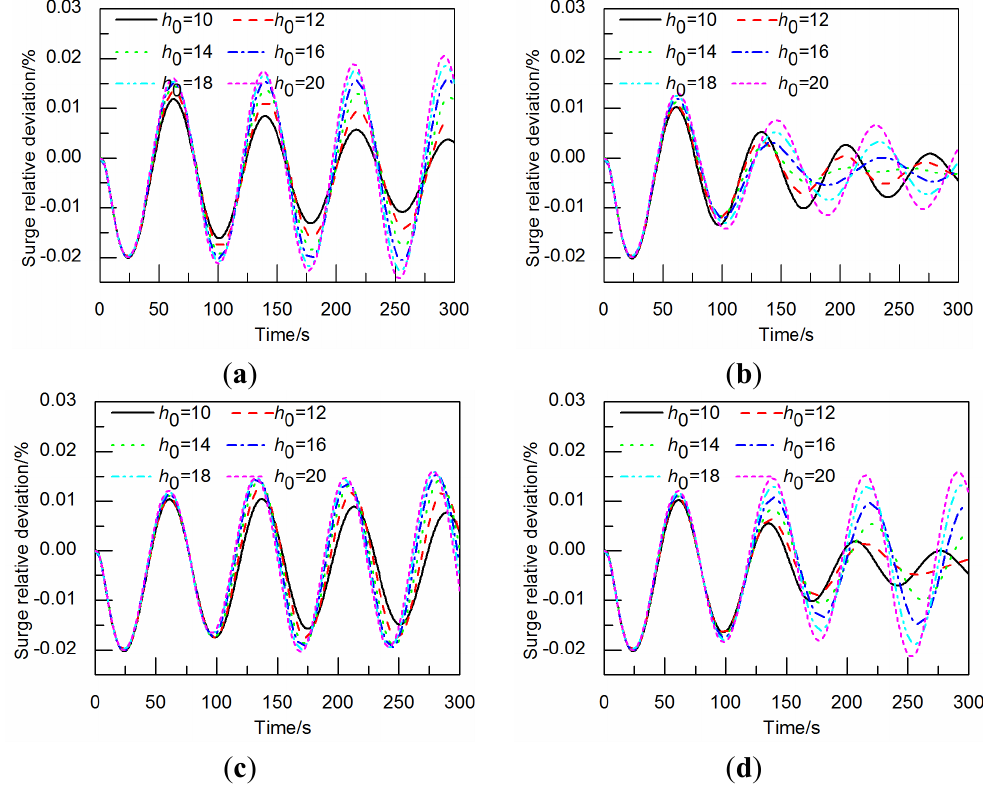
Figure 10. The influence of water depth in the open channel on the regulation quality: ( a ) L = 100 m; ( b ) L = 200 m; ( c ) L = 400 m; ( d ) L = 600